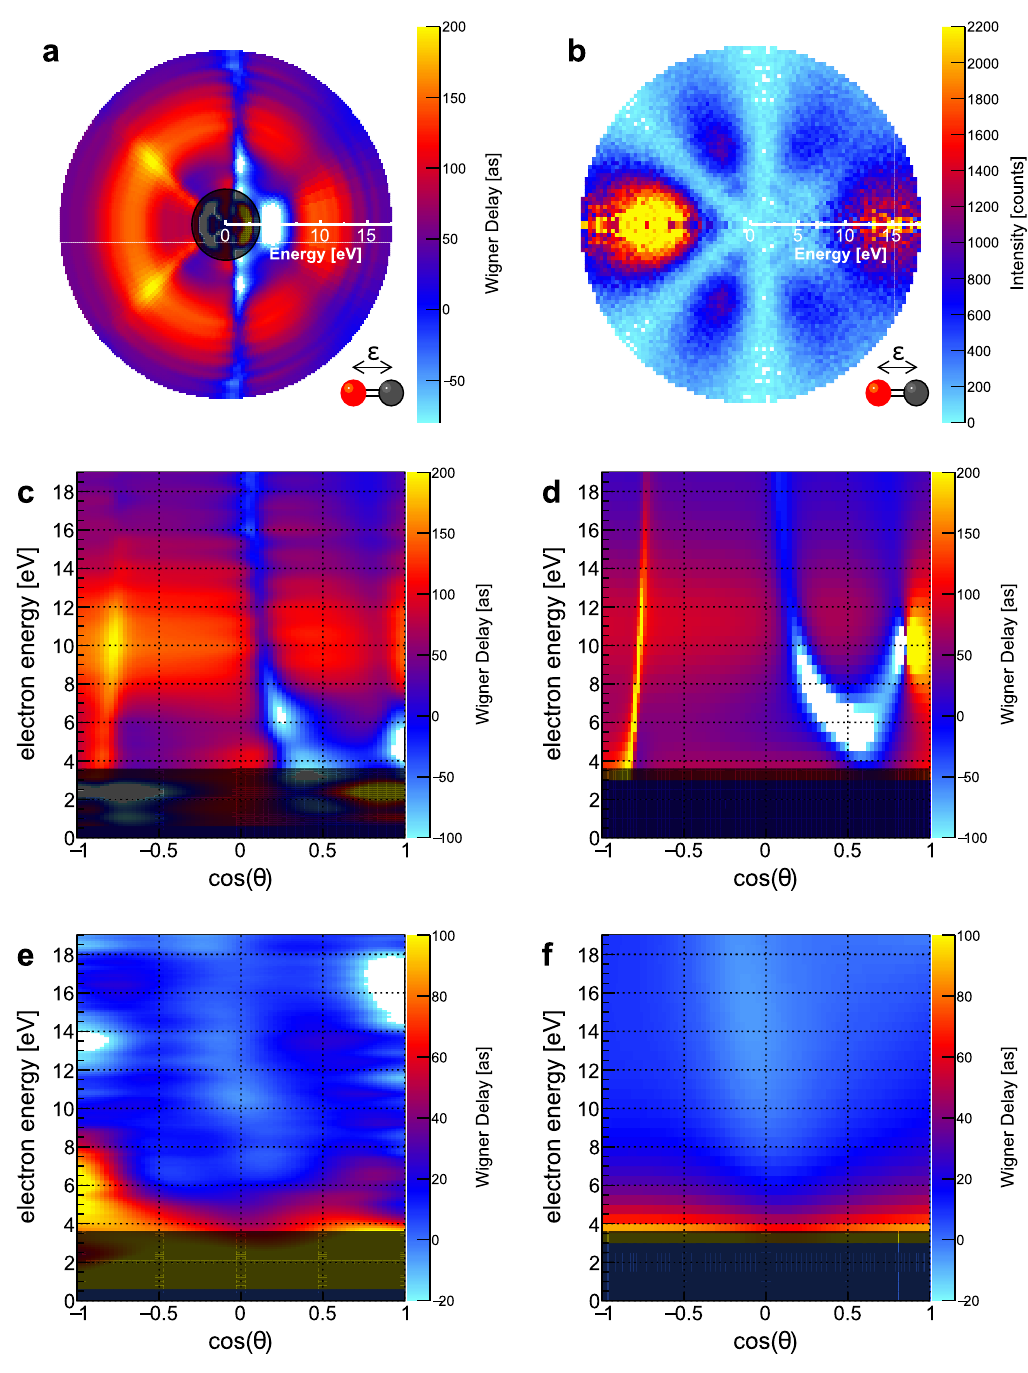
Fig. 3 Molecular-frame photoelectron angular distributions and Wigner delay maps. a – d The molecule is oriented along the light ’ s polarization axis. a Angle-dependent Wigner delay for a range of electron kinetic energies (resulting from a scan of the photon energy). The electron energy is encoded in the distance from the center, while the value in [as] is encoded in the color scale. b Polar map of the molecular-frame photoelectron angular distribution in a corresponding representation. Distinct features in the Wigner delay occur under emission angles which depict minima in the angular emission distribution. c The same as in a but in a conventional color map representation. d Associated Wigner color map obtained from our theoretical modeling. e , f The same as c and d but for molecules oriented perpendicularly to the polarization axis of the incoming photons. For the energy region below 3.5 eV a different theoretical model would be necessary. Therefore, this region is grayed out in a and c – f